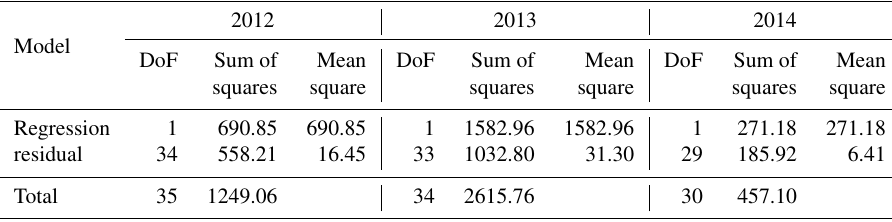
Table 3. Results of linear regression analysis between discharge and the DOC concentrations for the 2012–2014 sampling periods.